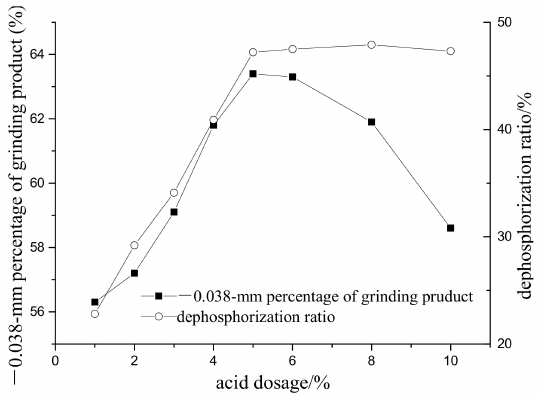
Figure 8. The − 0.038-mm percentage of grinding product and the dephosphorization ratio at different acid dosages.